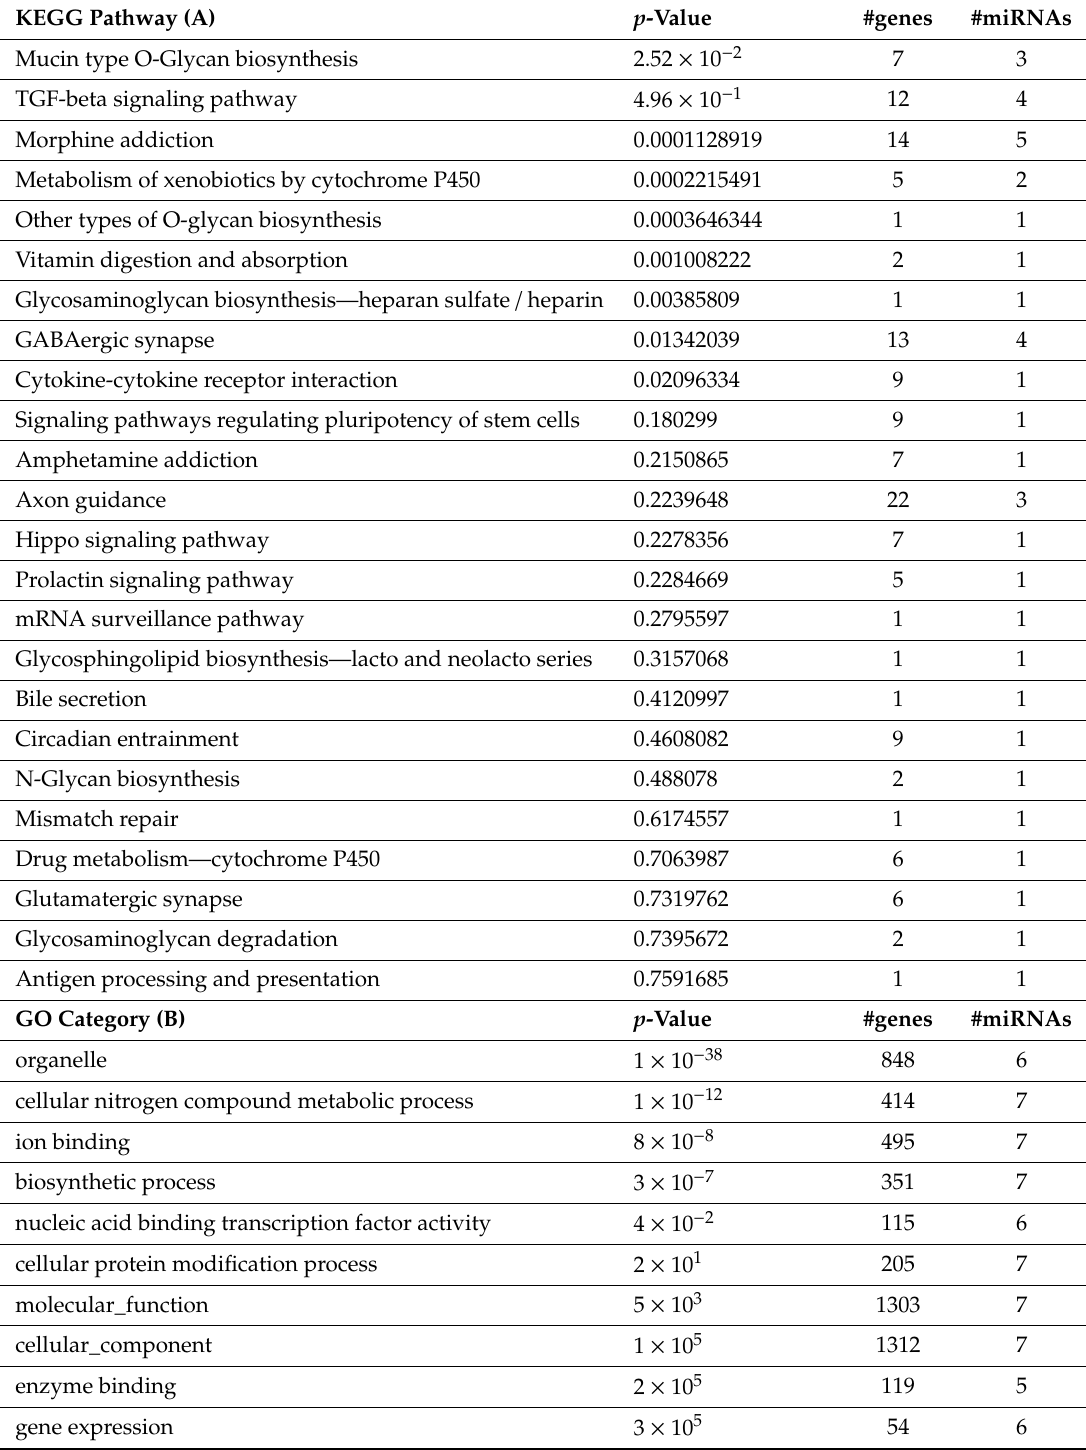
Table 2. The KEGG (A) and GO (B) enrichment analysis results for miR-8066, 5197-3p, 3611, 3934-3p, 1468-5p, 3691, and